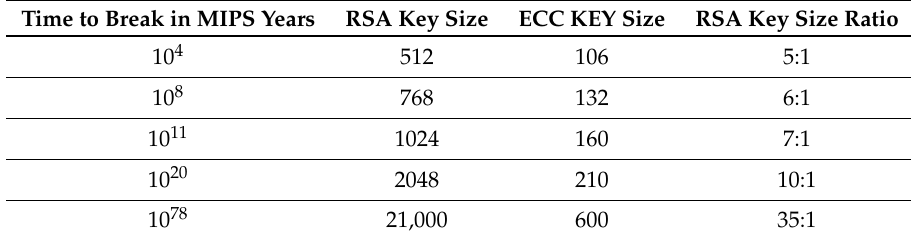
Table 1. Key size on equivalent strength between RSA and ECC.